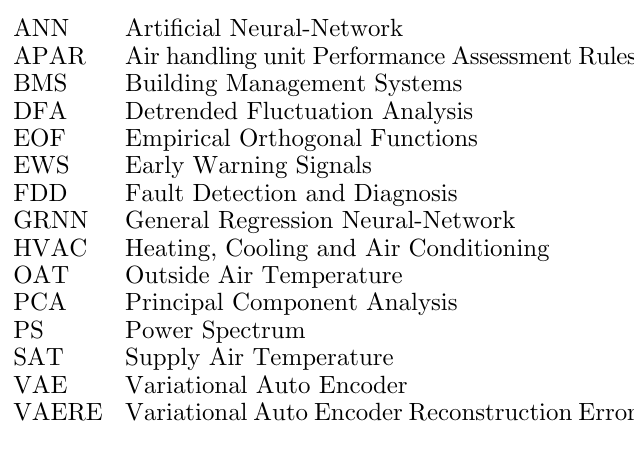
Fig. 5. Histogram of the frequency distribution of the Kendall trend statistic for the PS indicator for the multivariate case, for the different windows accross